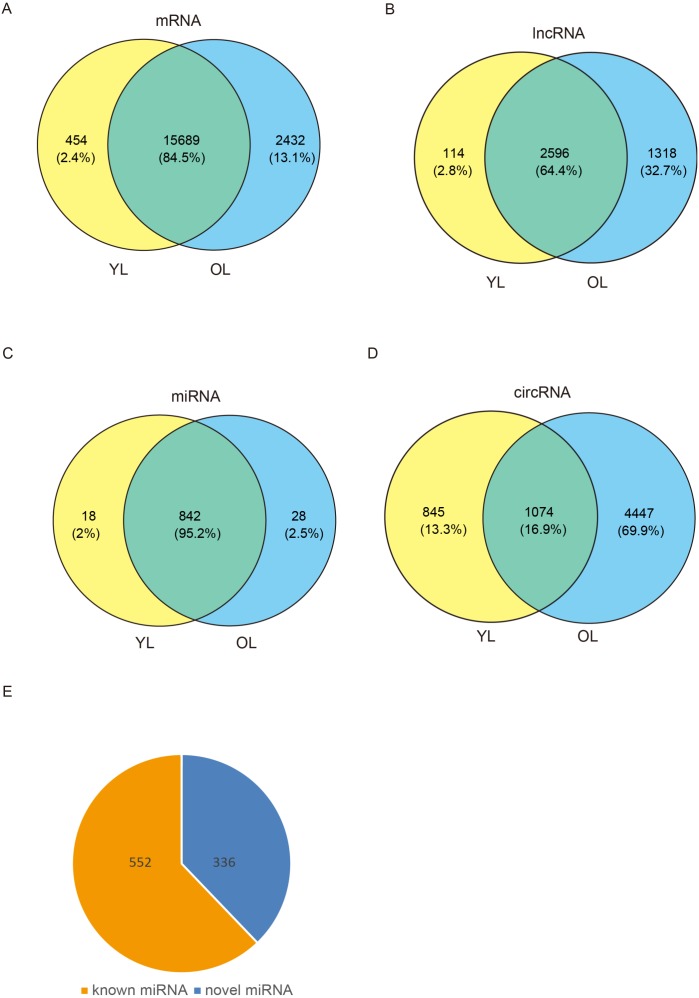
Global mRNA, lncRNA, miRNA, and circRNA expression patterns across liver samples.(A) mRNA. (B) lncRNA. (C) miRNA. (D) circRNA. (E) Known and novel miRNAs. YL, young liver; OL, old liver.